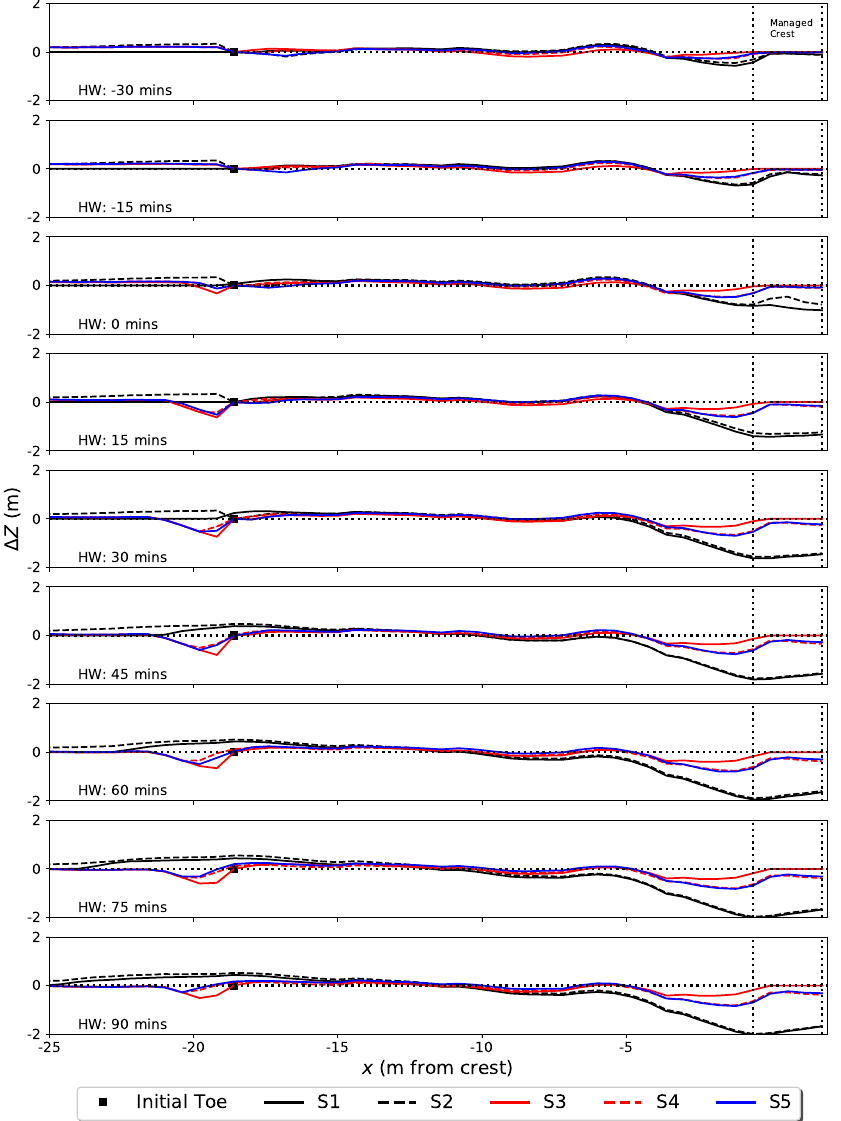
Figure 11. Nearshore elevation change ( ∆ Z ) across two hours either side of high water under S1–S5. Positive values represent accretion, and negative values represent erosion. The most extreme wave percentile combination is applied, H s ,98 and T p ,98 under highest astronomical tide. The dotted vertical lines denote the area of the crest that exceeds 7mODN, the height above which is artificially maintained to ensure sufficient width. The dotted horizontal line is 0m. The black square denotes the barrier toe at the start of the model